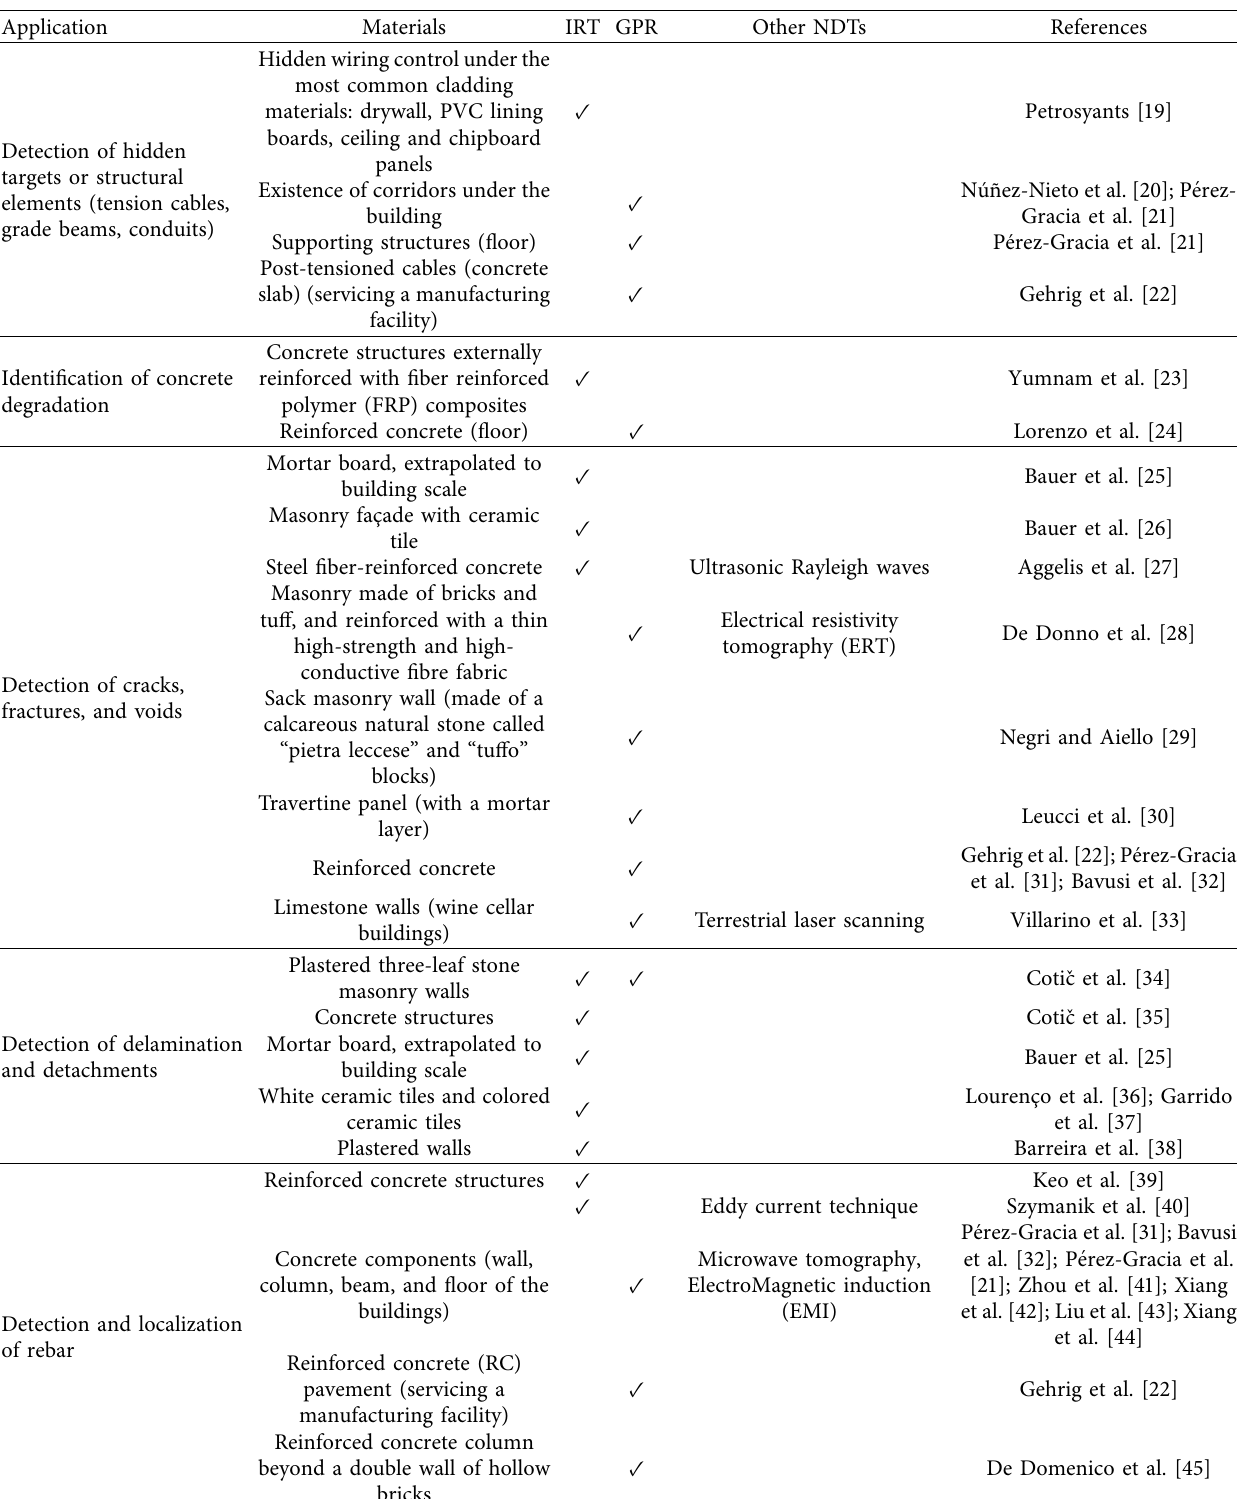
Table 2: Summary table of the state-of-the-art of IRT and GPR techniques applied to structural safety application in the building sector.